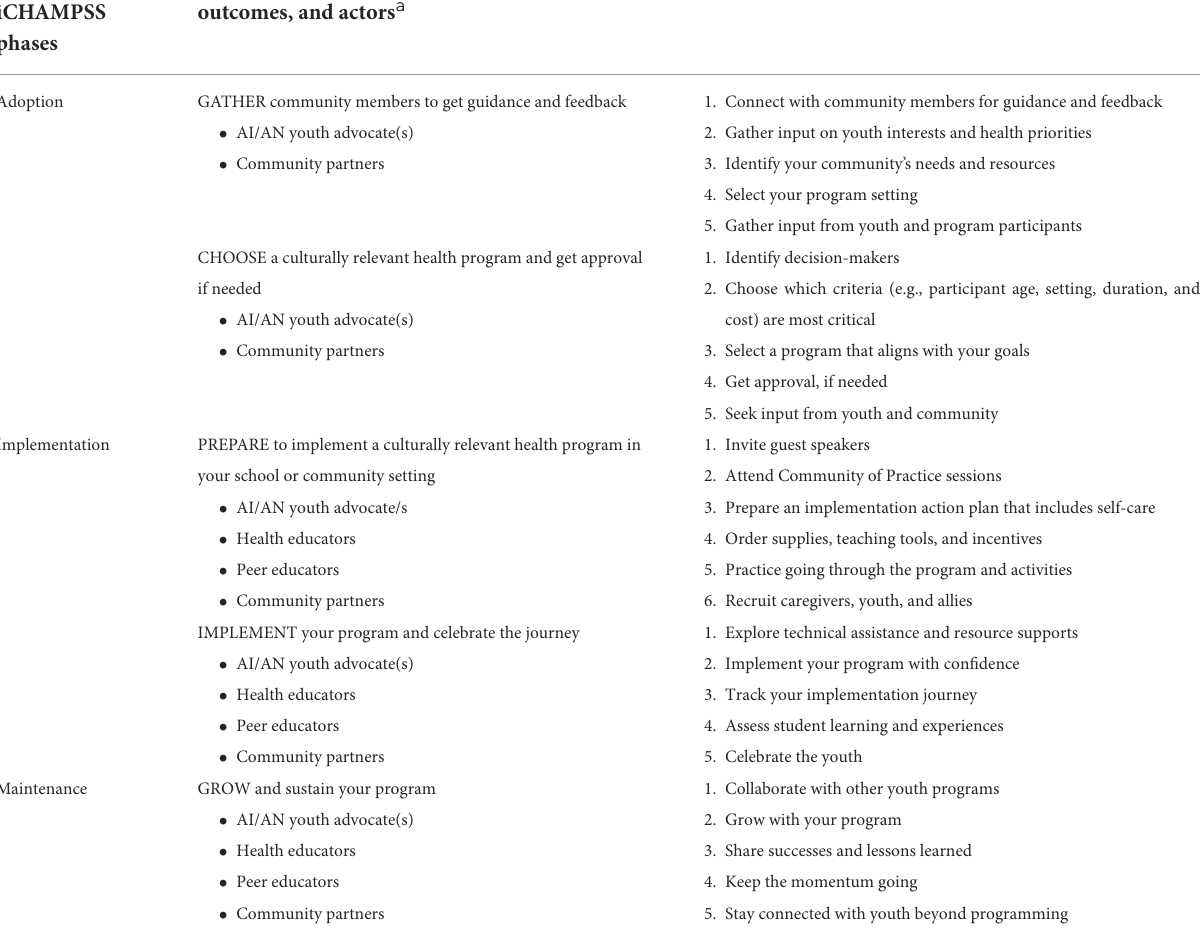
TABLE 2 Implementation Mapping Task 2: Adapted adoption, implementation, and maintenance outcomes, actors, and performance